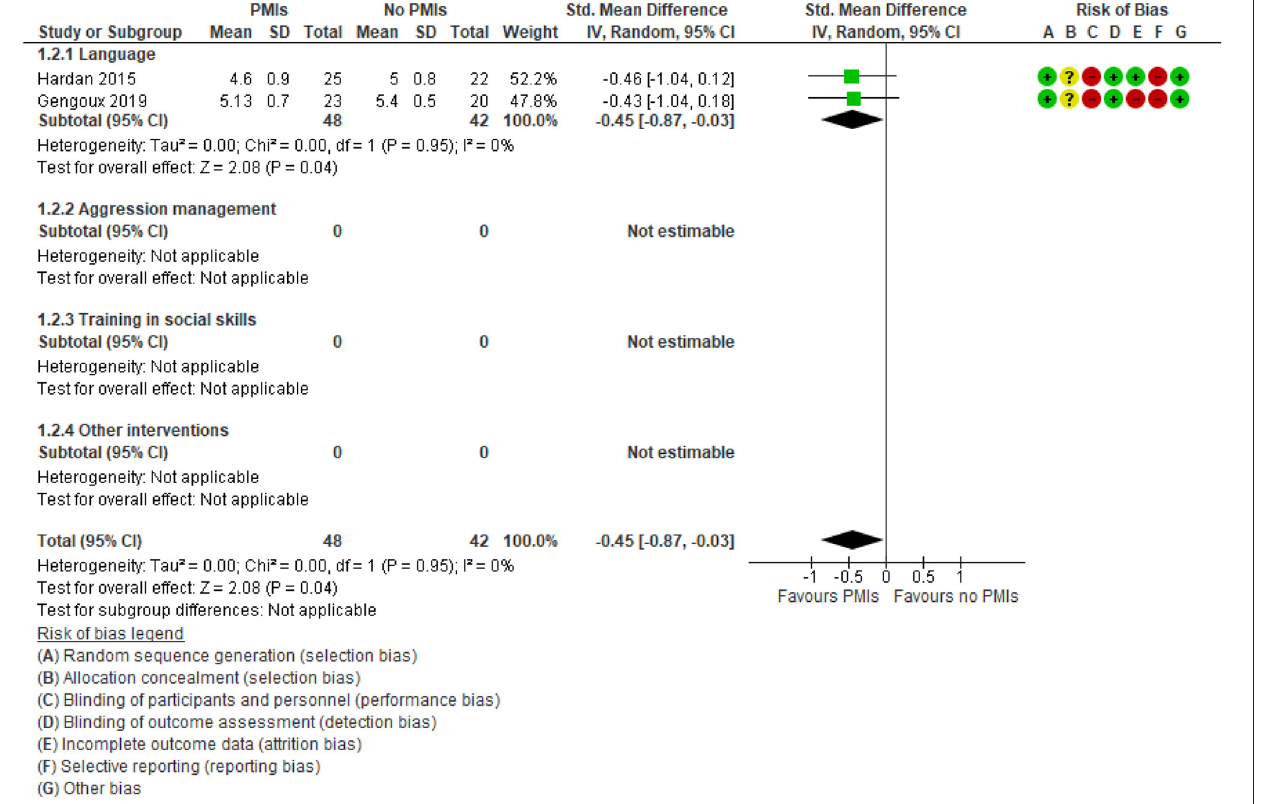
the Vineland scale of 3.5 [95% CI: 0.92, 6.02] calculated from the